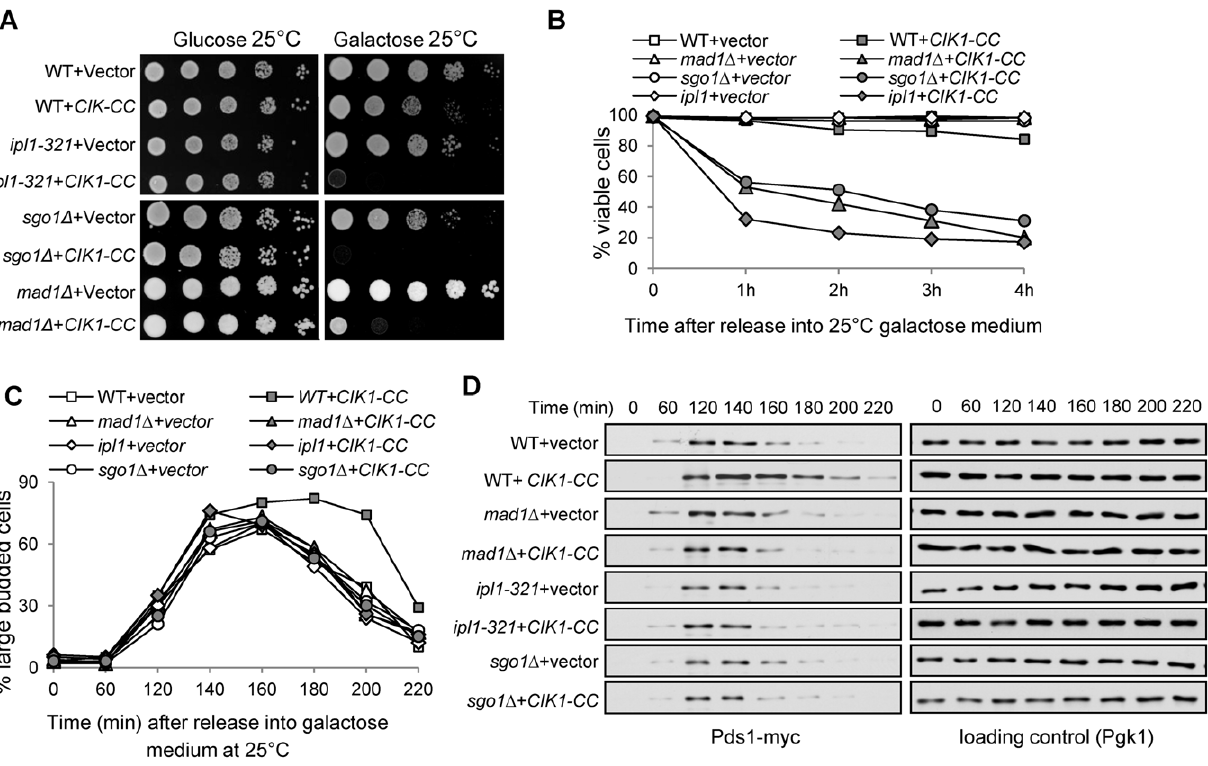
Figure 2. Overexpression of CIK1-CC results in checkpoint-dependent anaphase entry delay. A. Overexpression of CIK1-CC is lethal to mad1 D , ipl1-321 , and sgo1 D mutants. Serial 10-fold dilutions of WT and mutant cells with a vector or a P GAL CIK1-CC plasmid were spotted onto glucose and galactose plates and incubated for 3 days at 25 u C. B. mad1 D , ipl1-321 , and sgo1 D mutant cells lose viability after CIK1-CC overexpression. G 1 -arrested cells with the indicated genotypes were released into galactose medium and incubated at 25 u C. Cells were collected at the indicated time points and spread onto YPD plates. After overnight growth, the plating efficiency was determined and the percentage of viable cells is shown. C and D. Checkpoint mutants alleviate the Pds1 degradation delay induced by CIK1-CC overexpression. G 1 -arrested WT, mad1 D , ipl1-321 , and sgo1 D cells containing Pds1-18myc as well as a vector or a P GAL CIK1-CC plasmid were released into galactose medium and incubated at 25 u C. a -factor was restored after budding to block the second round of cell cycle. Cells were collected at the indicated time points and protein samples were prepared for Western blotting. The budding index is shown in C and Pds1 levels are shown in D. Pgk1 protein levels were used as a loading control.